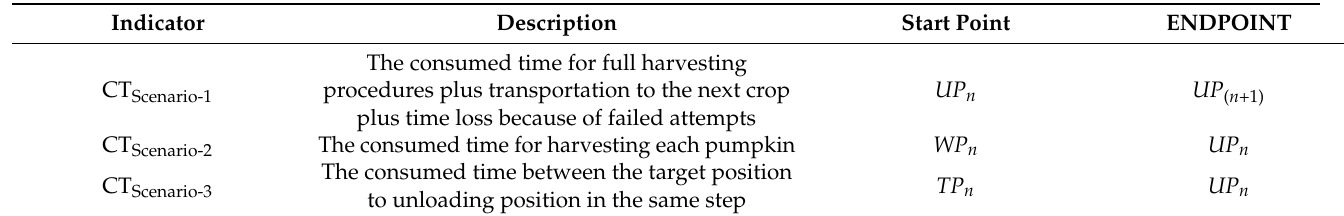
Figure 5. Illustration of controlling procedure with different scenarios for cycle time. Table 3. Harvesting performance